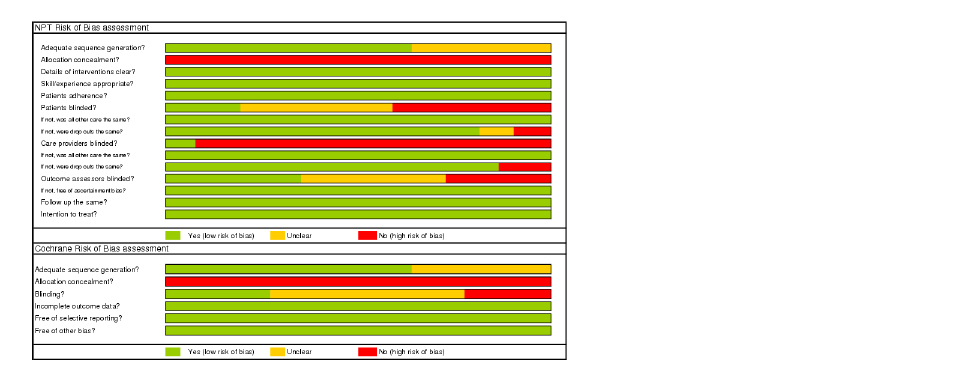
Fig 4. Risk of bias tables for CLEAR NPT and Cochrane.